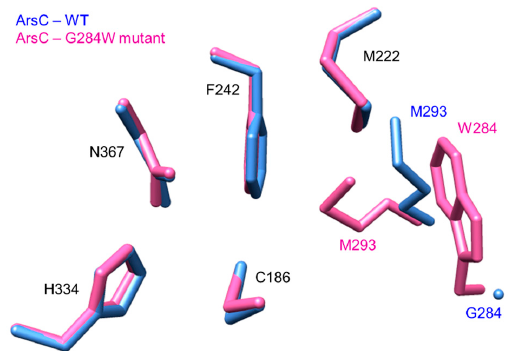
Figure 13. Active site cavity of ArsC-WT (blue, PDB ID: 3VS8) and ArsC-G284W mutant (pink, PDB ID: 3VS9). The Cys-His-Asn catalytic triad remained in their positions; the absence of tryptophan in